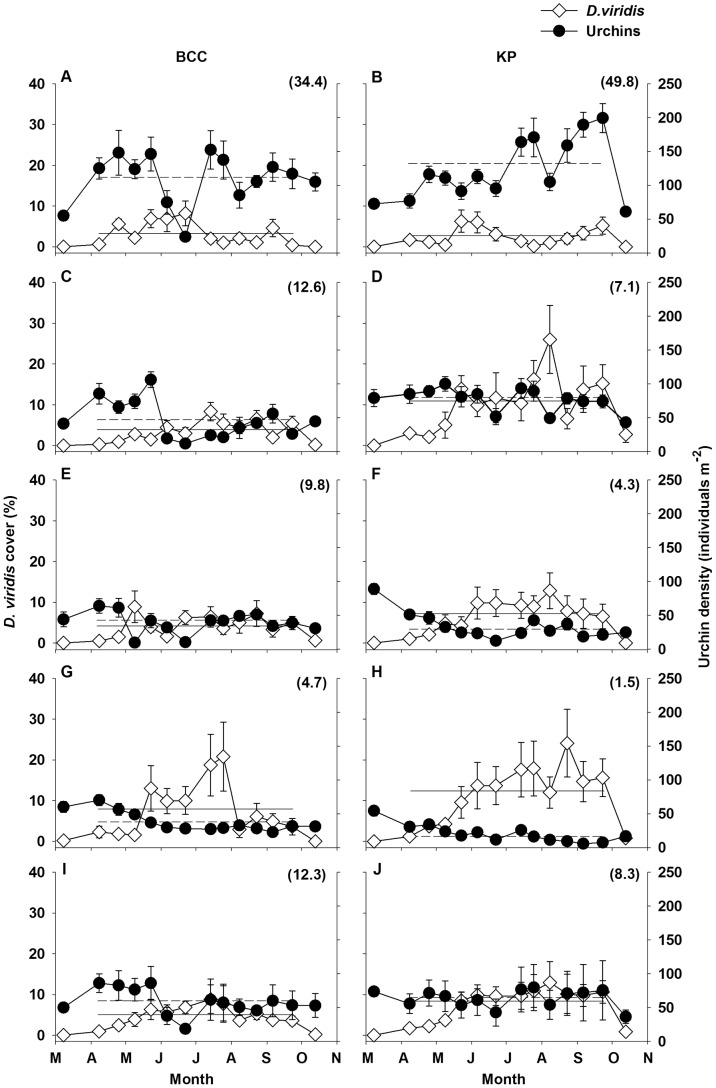
Mean (±SE) Desmarestia viridis cover and urchin (Strongylocentrotus droebachiensis) density at 2 (A, B), 3 (C, D), 4 (E, F), and 8 (G, H) m depths, and averaged across all depths (I and J) at Bread and Cheese Cove (BCC) and Keys Point (KP) from 8 March to 13 October, 2011.Each data point in panels A to H is the average cover of D. viridis or urchin density in 10 quadrats (0.8 m2 each) from two transects (20 to 25 m) at each depth. The seeming lack of standard error on some data points is due to low data variation. Solid and dashed horizontal lines are the average D. viridis cover and urchin density, respectively, from 8 April to 23 September (12 data points; see “Materials and methods” for the details of restriction of the statistical analyses to these points). The number in parentheses within each panel is the ratio of urchin density to D. viridis cover, also from 8 April to 23 September.